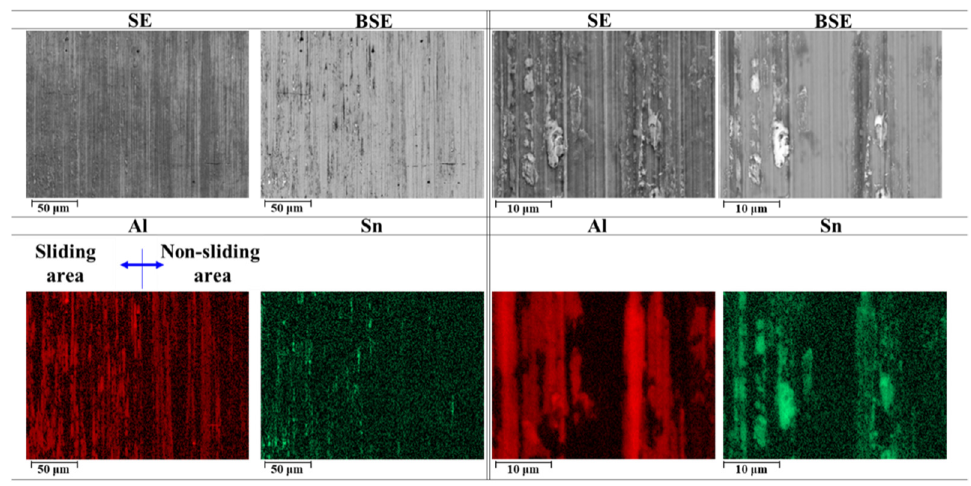
Figure 17. EDX analysis of steel journal surface after occurrence of first torque spike.